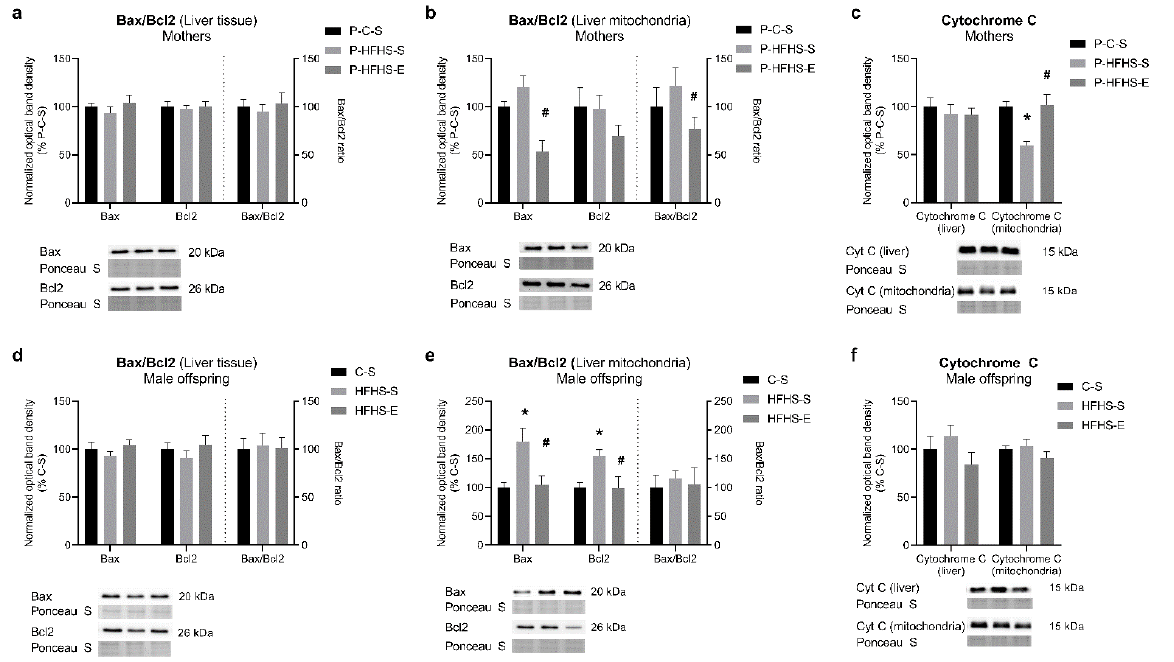
Figure 6. Effects of maternal HFHS and GE on the protein expression of different markers of apoptotic signalling in mothers: ( a ) relative content of liver Bax and Bcl2 and their ratio, ( b ) relative content of liver mitochondrial Bax and Bcl2 and their ratio, ( c ) relative content of liver and liver mitochondrial cytochrome c; and in offspring: ( d ) relative content of liver Bax and Bcl2 and their ratio, ( e ) relative content of liver mitochondrial Bax and Bcl2 and their ratio, ( f ) relative content of liver and liver mitochondrial cytochrome c. GE — gestational exercise; C — mothers fed with control diet; HFHS — mothers fed with high-fat high-sucrose diet; S — sedentary mothers; E — exercised mothers. * vs. P-C-S ( p < 0.05) or vs. C-S ( p < 0.05) in mothers or offspring, respectively. # vs. P-HFHS-S ( p < 0.05) or vs. HFHS-S ( p < 0.05) in mothers or offspring, respectively.